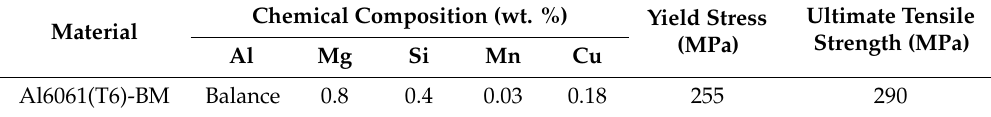
Table 1. Chemical compositions and tensile properties of the base material (BM).